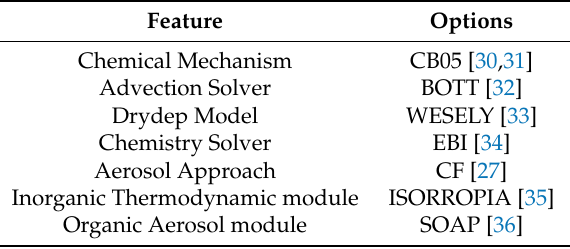
Table 1. Selected configuration for CAMx